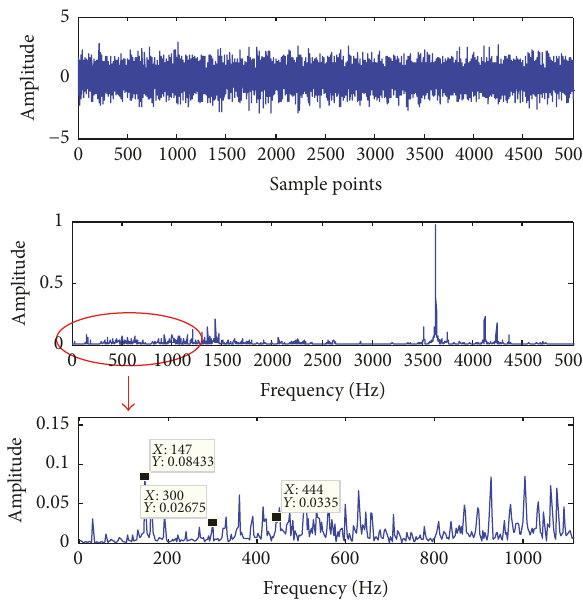
Figure 13: The time domain and spectrum of experimental